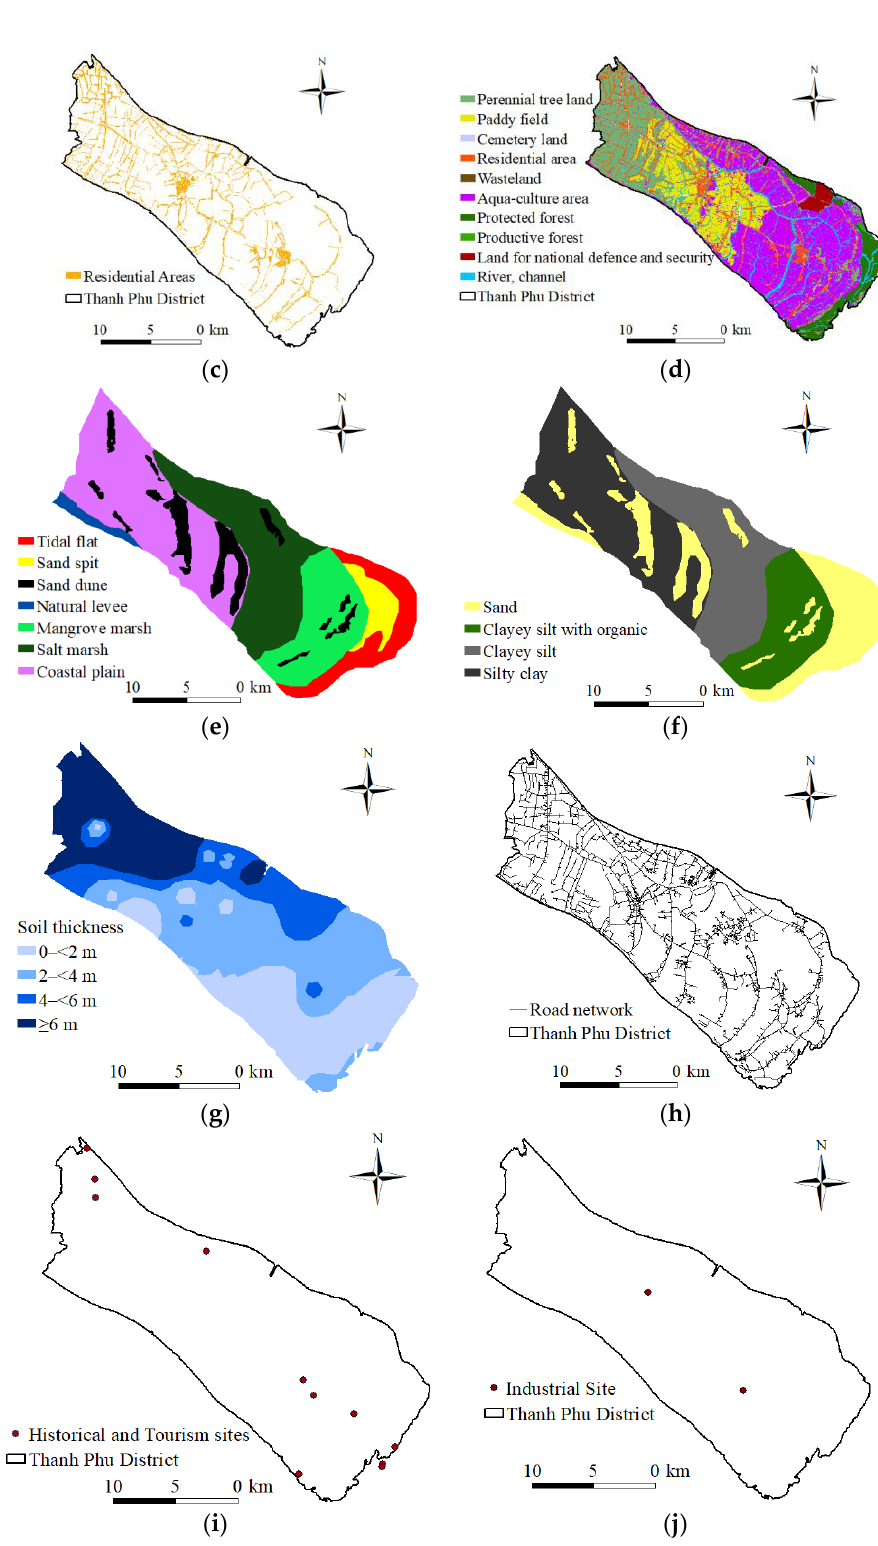
Figure 3. Collected data for describing criteria: Surface water network ( a ); locations of collected boreholes ( b ); distribution of residential areas ( c ); land use types ( d ); geomorphological maps ( e ); surface soil types based on geomorphological map ( f ); distribution of surface soil thickness ( g ); road network ( h ); locations of historical and tourism sites ( i ); locations of industrial sites ( j ).